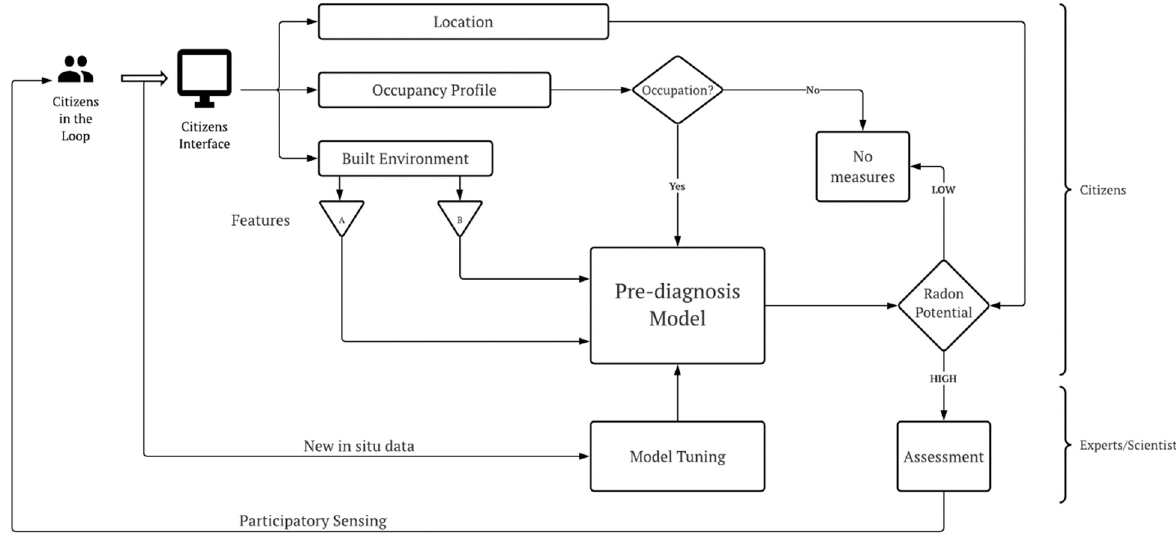
Figure 2. Implementation of a pre-diagnosis tool for indoor radon potential assessment.